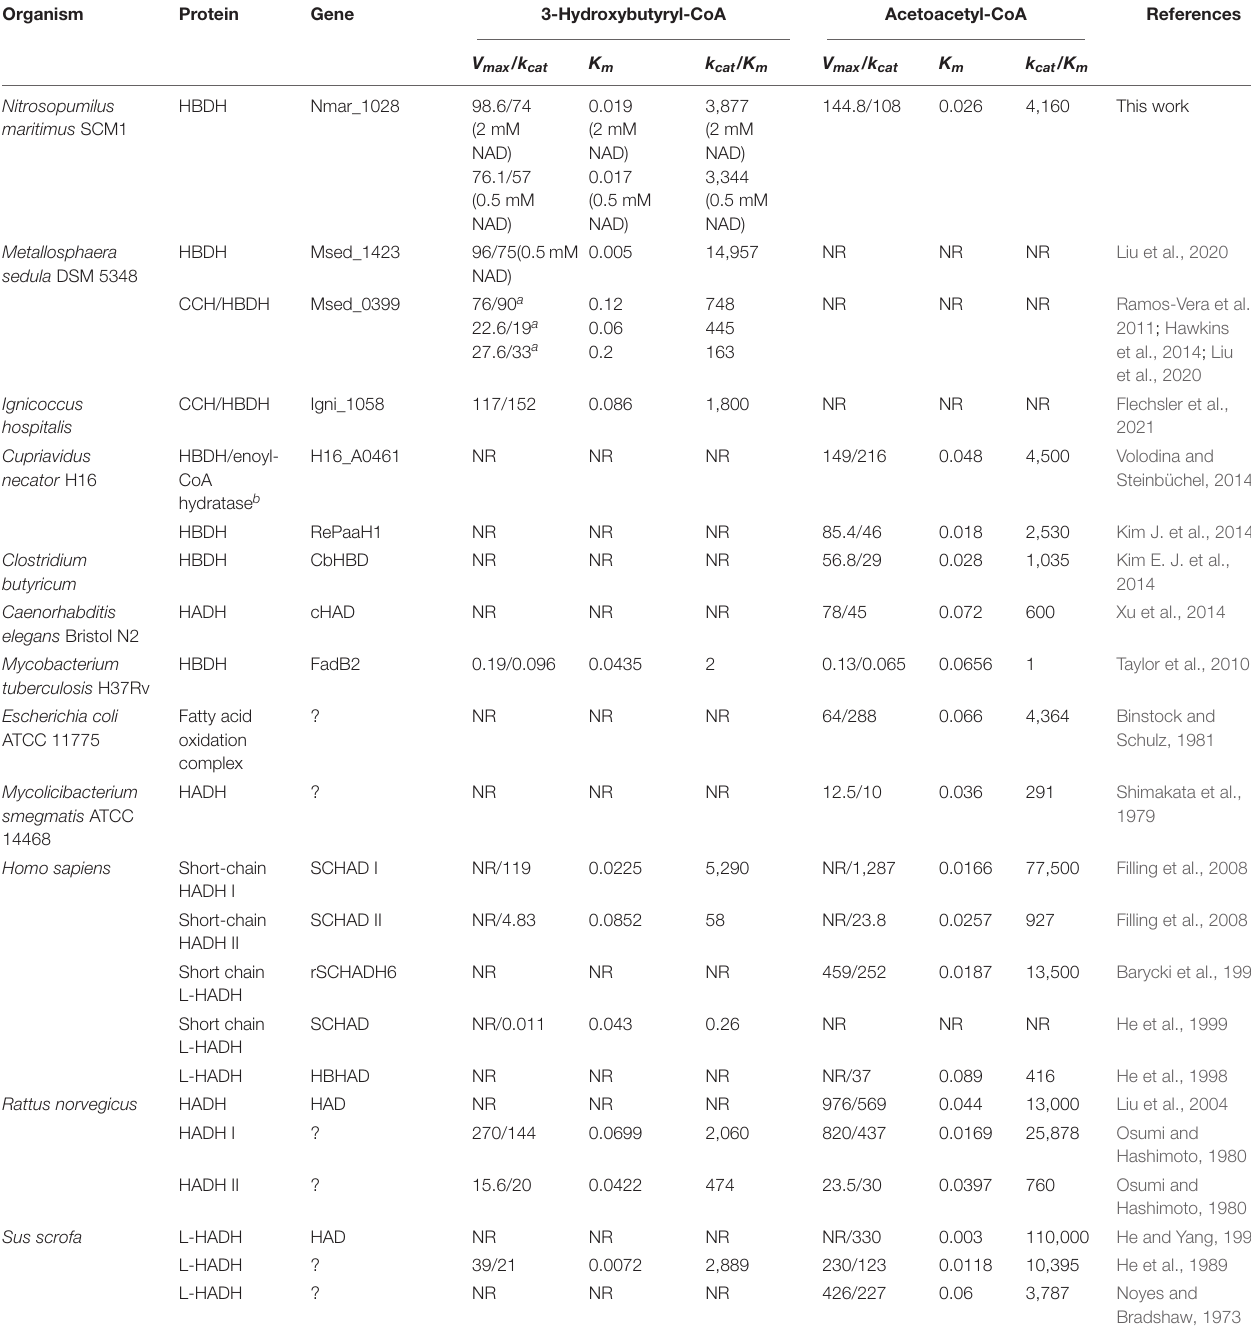
TABLE 3 | Catalytic properties of various so-far-characterized 3-hydroxyacyl-CoA dehydrogenases toward 3-hydroxybutyryl-CoA and/or acetoacetyl-CoA. Organism Protein Gene